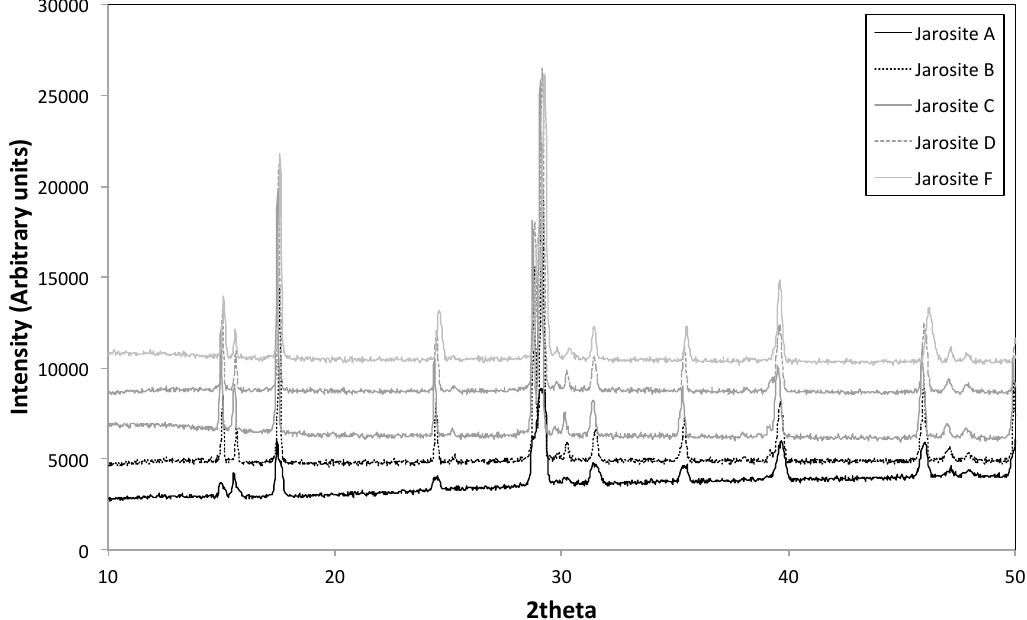
Figure 5. XRD pattern of solids obtained on initial addition of up to 0.9 mole fraction Al. Patterns have been offset in the y -direction for clarity.